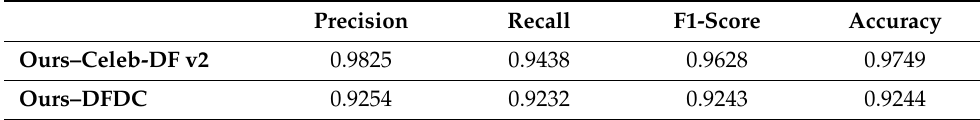
Table 4. Benchmark